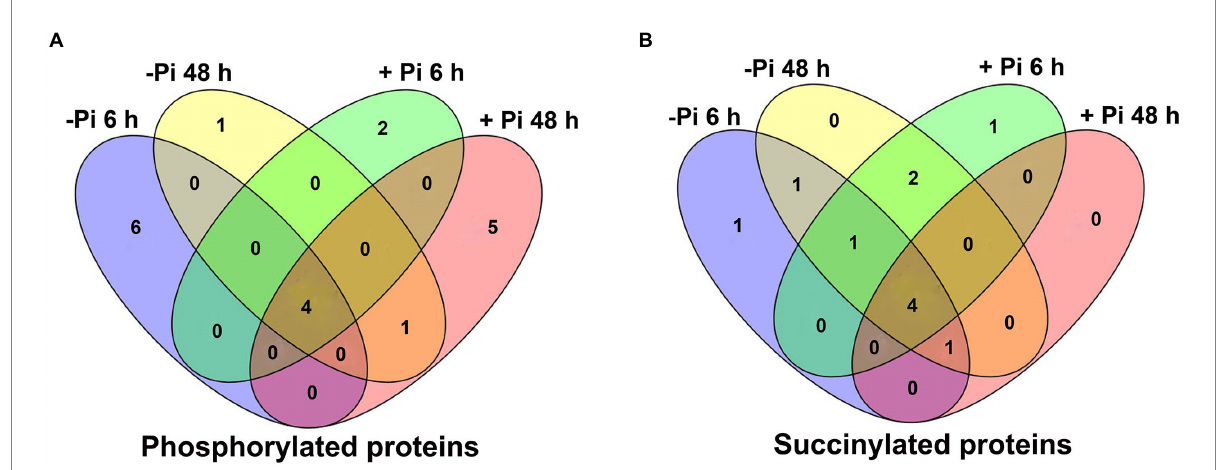
FIGURE 3 Venn diagram representing the overlap of differentially expressed metabolic pathways in Pi starvation (–Pi) for 6 h and 48 h, and Pi recovery (+Pi) for 6 h and 48 h with regard to phosphorylated (A) and succinylated (B) proteins, respectively. Pi, intracellular